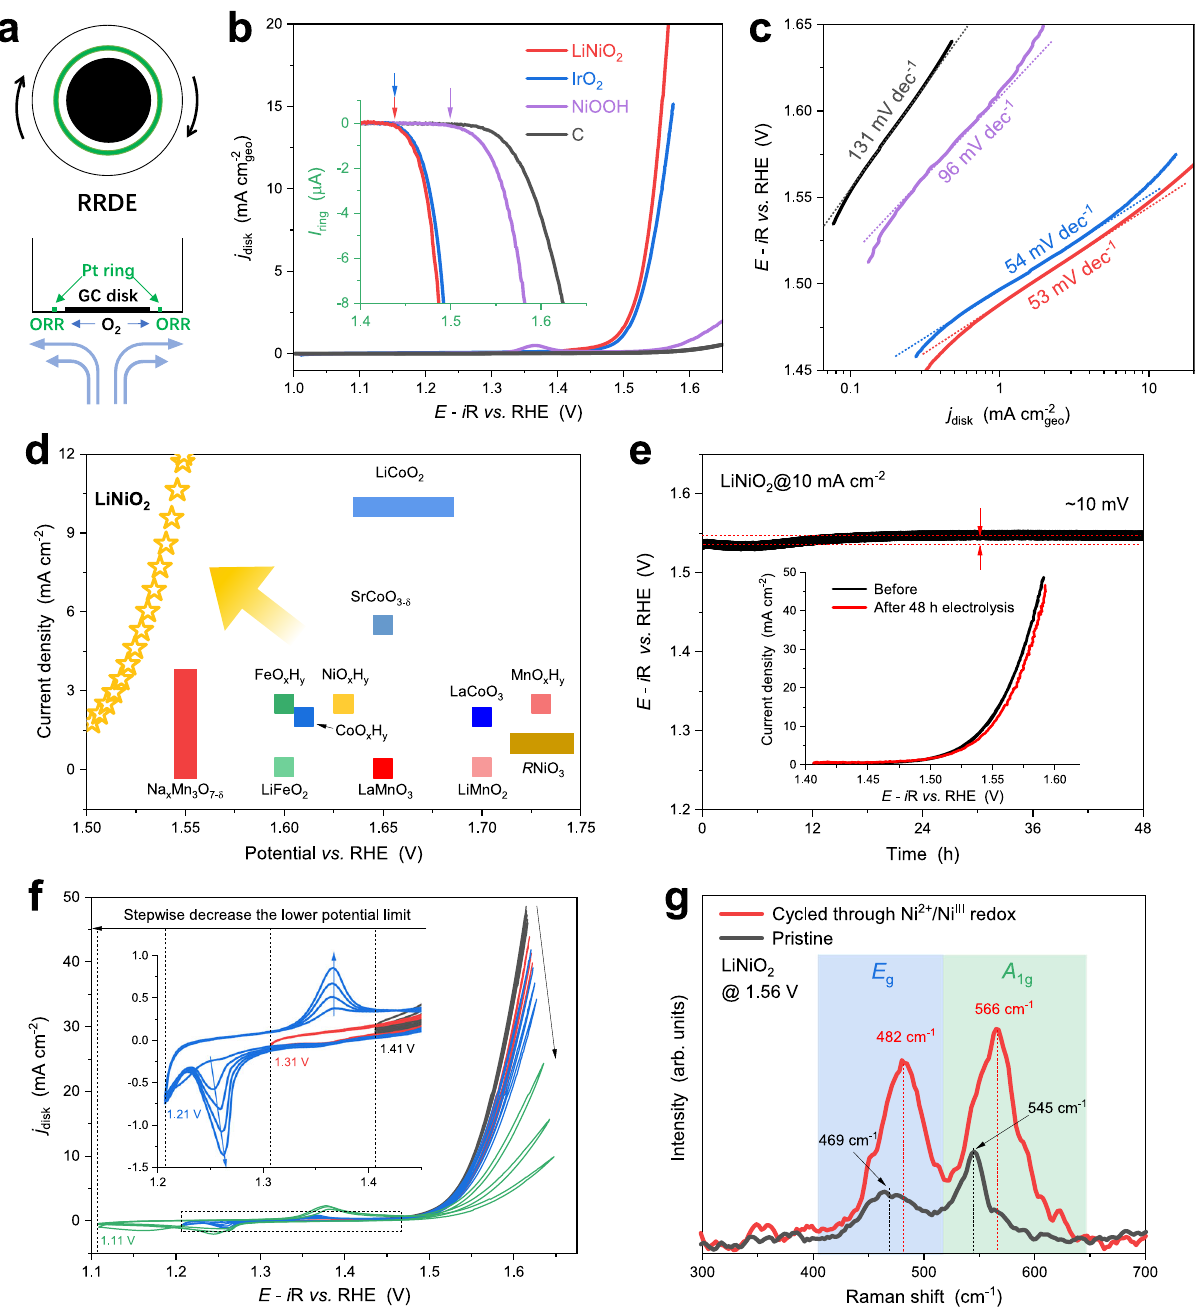
Fig. 4 | Electrochemical measurements and surface chemistry of LiNiO 2 . carbon paper) and (the inset of e ) linear sweep voltammograms of LiNiO 2 before a Schematicillustrationofarotatingringdiskelectrode(RRDE,ring:Pt,disk:glassy and after the stability test. f Window-opening cyclic voltammograms of LiNiO 2 in Fe-free 1M KOH with stepwise decreasing the lower potential limits, showing the carbon). b Linear sweep voltammograms and c Tafel plots of LiNiO 2 , NiO-derived NiOOH, IrO 2 (99.9% metal basis, Adamas-beta) and carbon (Vulcan XC-72R) in Ar- evolution of redox peaks (magni fi ed in the corresponding insets) and the dete- saturated1MKOHsolution,alongwiththecorrespondingPtringcurrentshownin riorationofOERcurrent.Thevoltammogramswerecollectedunder1600rpmwith the inset (the onset potential of OER indicated by arrows). d OER activity com- a sweep rate of 5mVs − 1 , and IR drops of the voltammograms were determined by parison of the as-prepared LiNiO 2 to LiMO 2 (M=Co and Fe), and R MO 3 ( R =Rare EIS prior to the measurements and compensated. g Operando Raman spectra of earth elements, M=Fe, Co and Ni) and other unary 3d transition metal catalysts LiNiO 2 at 1.56V with and without being cycled through Ni 2+ /Ni III (Supplementary Table 3). e Stability test of LiNiO 2 in 1M KOH at 10mAcm − 2 (on fi rst-shell coordination in pristine LiNiO 2 is saturated with six oxygen